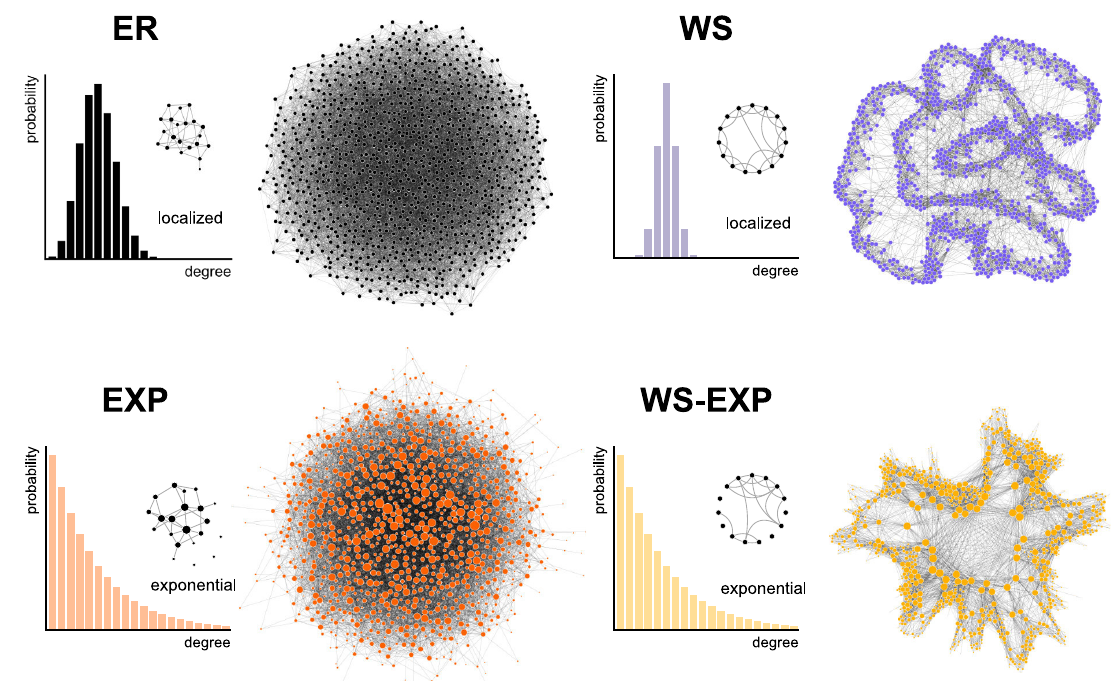
Fig 2. We analyzed the efficacy of DCT on four different network topologies: Erd ő s–R é nyi networks (ER, low clustering and narrow (binomial) degree distribution), Watts–Strogatz–like small-world networks (WS, high clustering, narrow degree distribution), configurational model random networks with exponential degree distribution (EXP), and WS-like networks with high clustering and exponential degree distribution (WS-EXP).